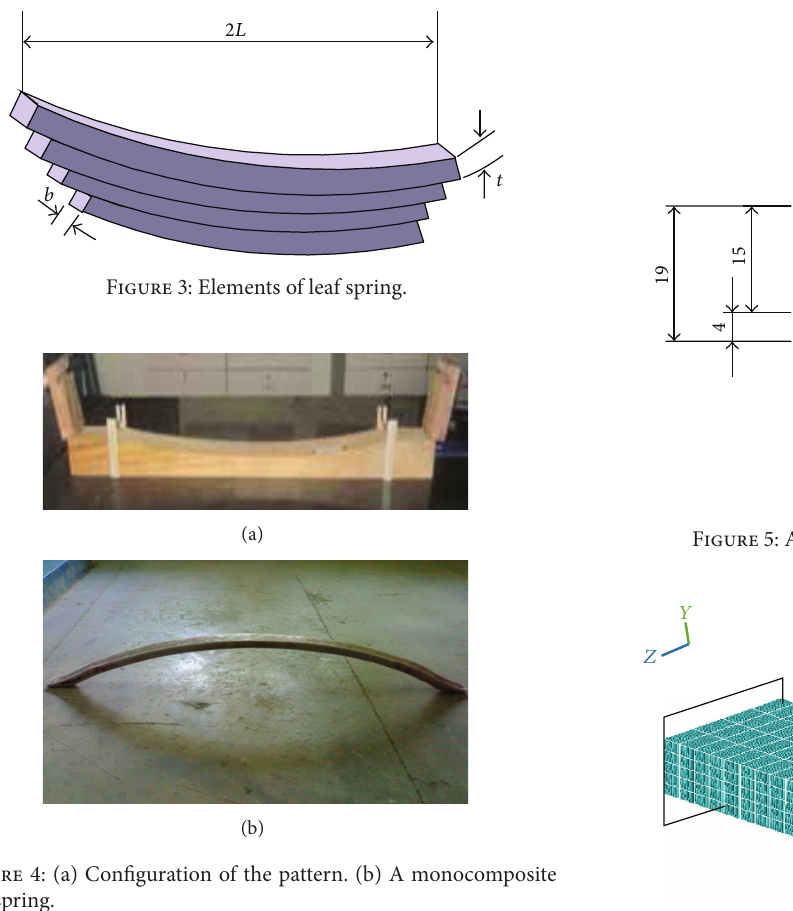
Figure 6: Meshing and boundary conditions of the ANSYS